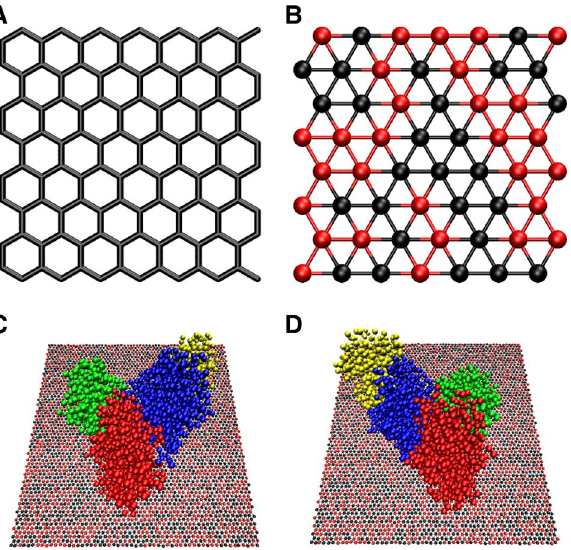
Figure 6. The atomistic structure of graphene ( A ) and coarse-grained structure of GO nanosheets ( B ) and images of ( C ) and ( D ) show the first and second orientations of GO nanosheets and actin